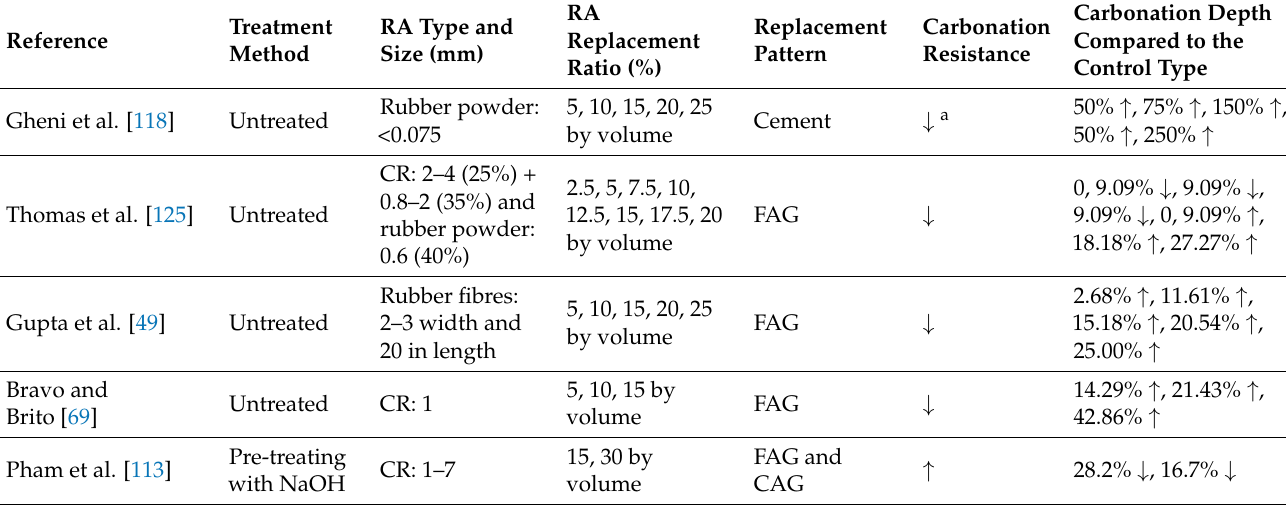
Table 11. Influence of rubber on the concrete carbonation